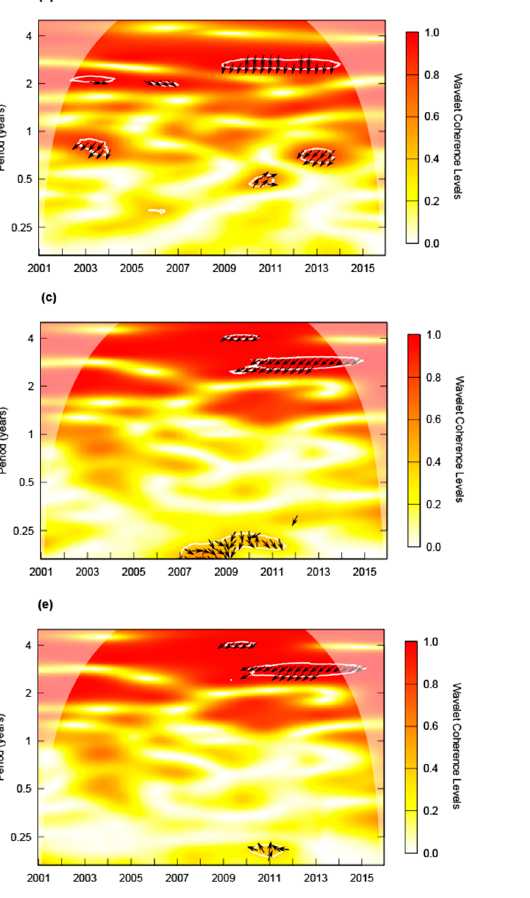
Figure 5. Wavelet coherence between ENSO–SPEI1 in 2001–2015. ( a ) Niño 1 + 2–SPEI1, ( b ) Niño 3–SPEI1, ( c ) Niño 3.4–SPEI1, ( d ) Niño 4–SPEI1, ( e ) ONI–SPEI1, ( f ) SOI–SPEI1.